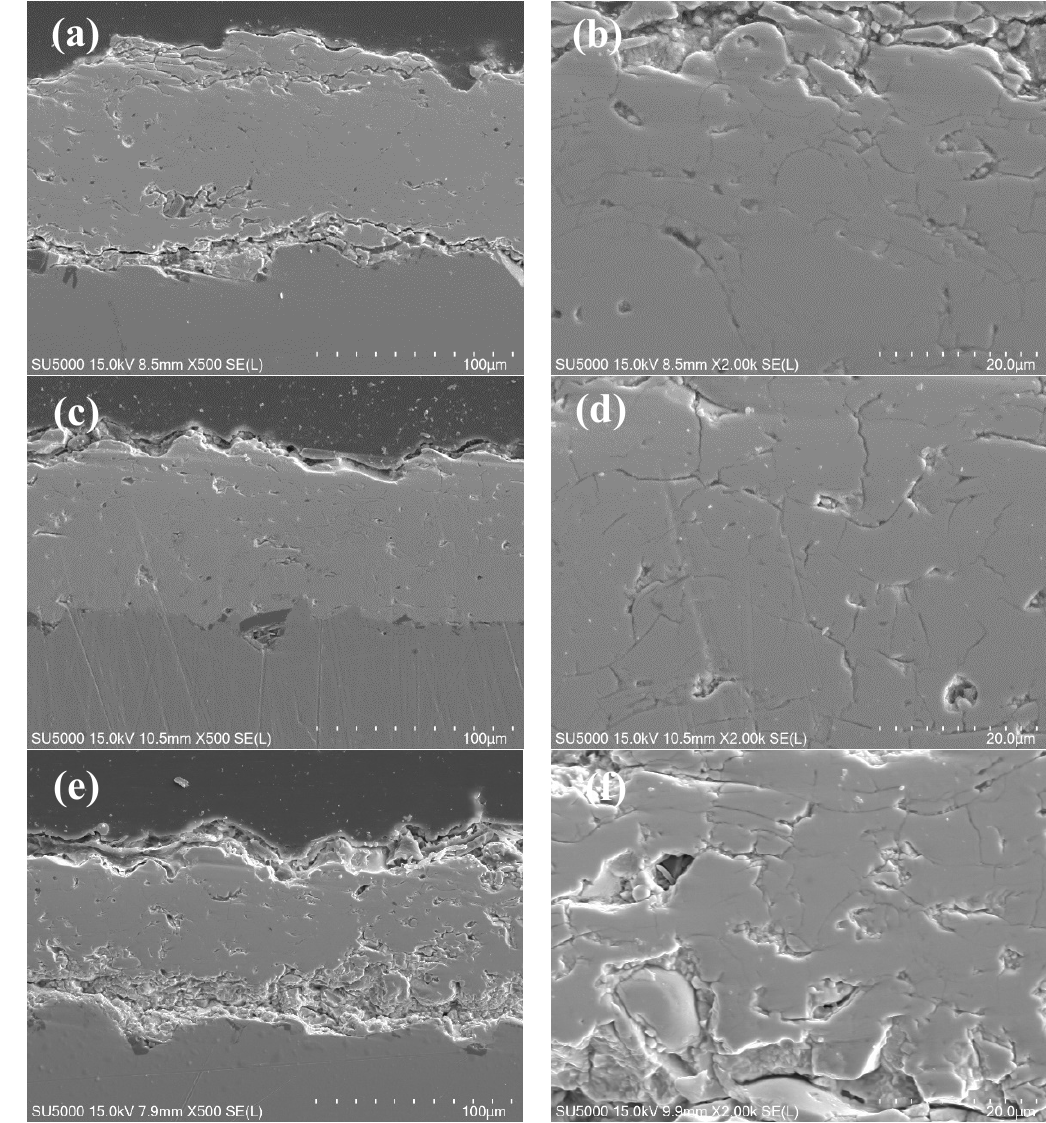
Figure 3. Cross-section morphologies of thermal barrier coatings deposited at different spray distances: ( a , b ) 90 mm, ( c , d ) 100 mm, and ( e , f ) 110 mm.